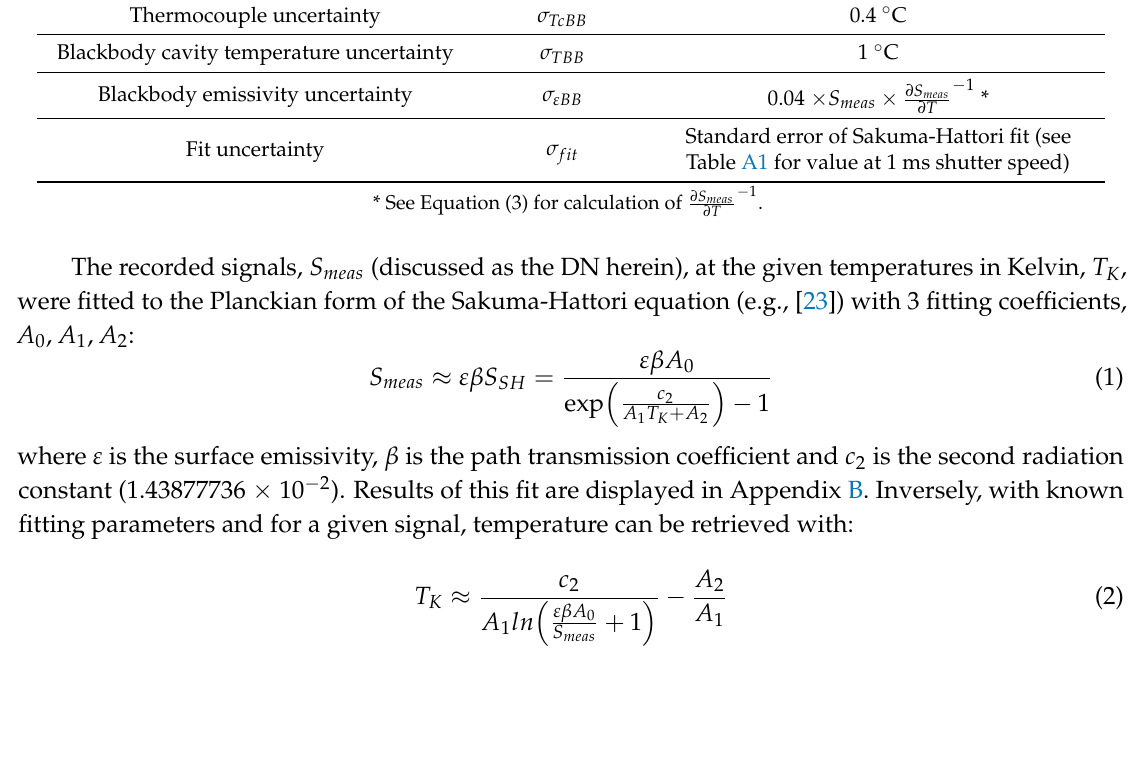
Table 1. Calibration Uncertainties.